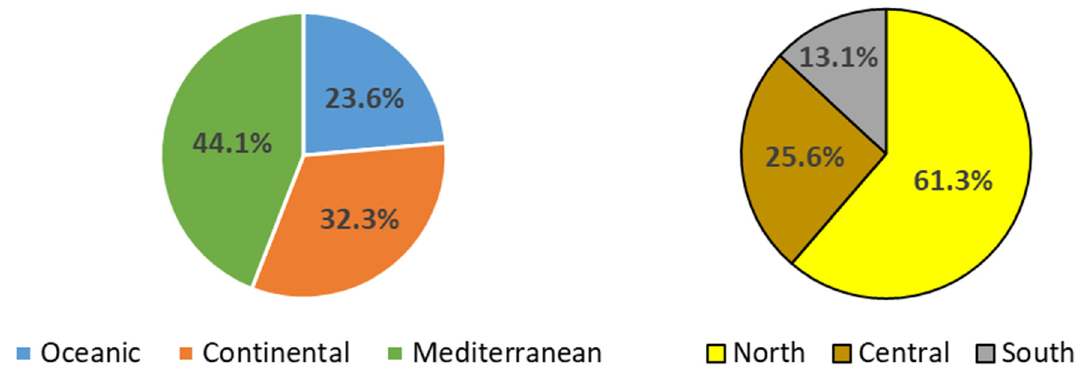
Figure 10. Distribution of cases by type of climate ( left ) and by latitude within Spain ( right ).